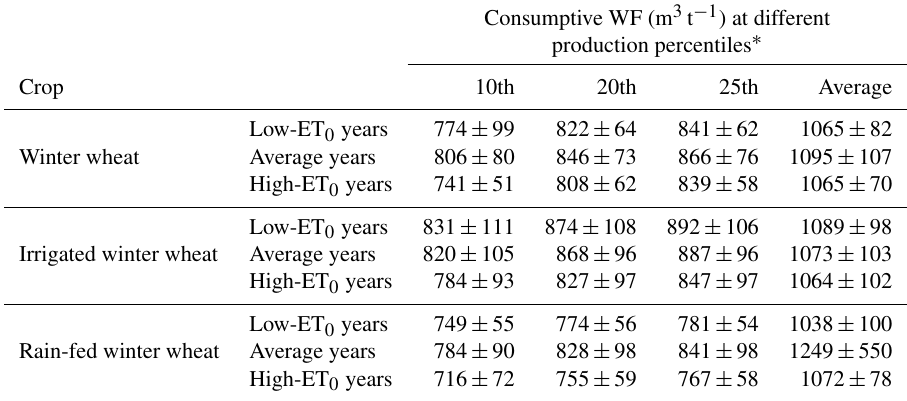
Table 4. National consumptive water footprint (WF) benchmarks (m 3 t − 1 ) of winter wheat for relative low-, high-, and average-ET 0 years in